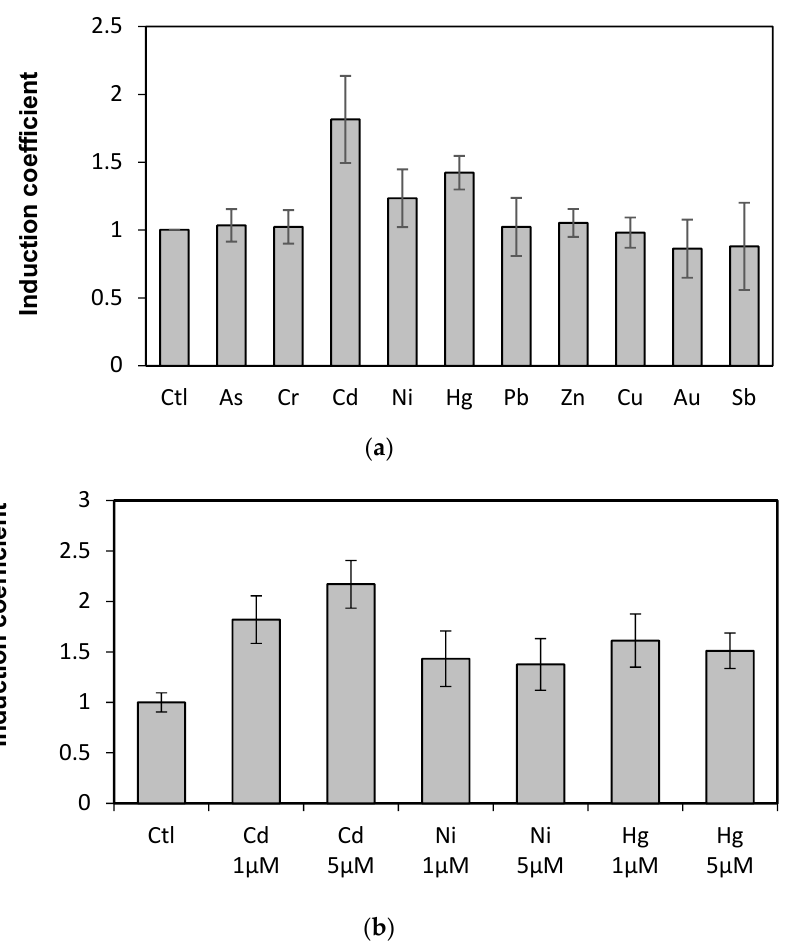
Figure 2. Induction coefficients from E. coli cells harboring eGFP-loop2 exposed to metal ions. ( a ) Responses of engineered eGFP-loop2 to various metal(loid) ions. ( b ) Induction coefficients of eGFP-loop2 to different concentrations of Cd, Ni, and Hg. (Ctl, control without metal ions).